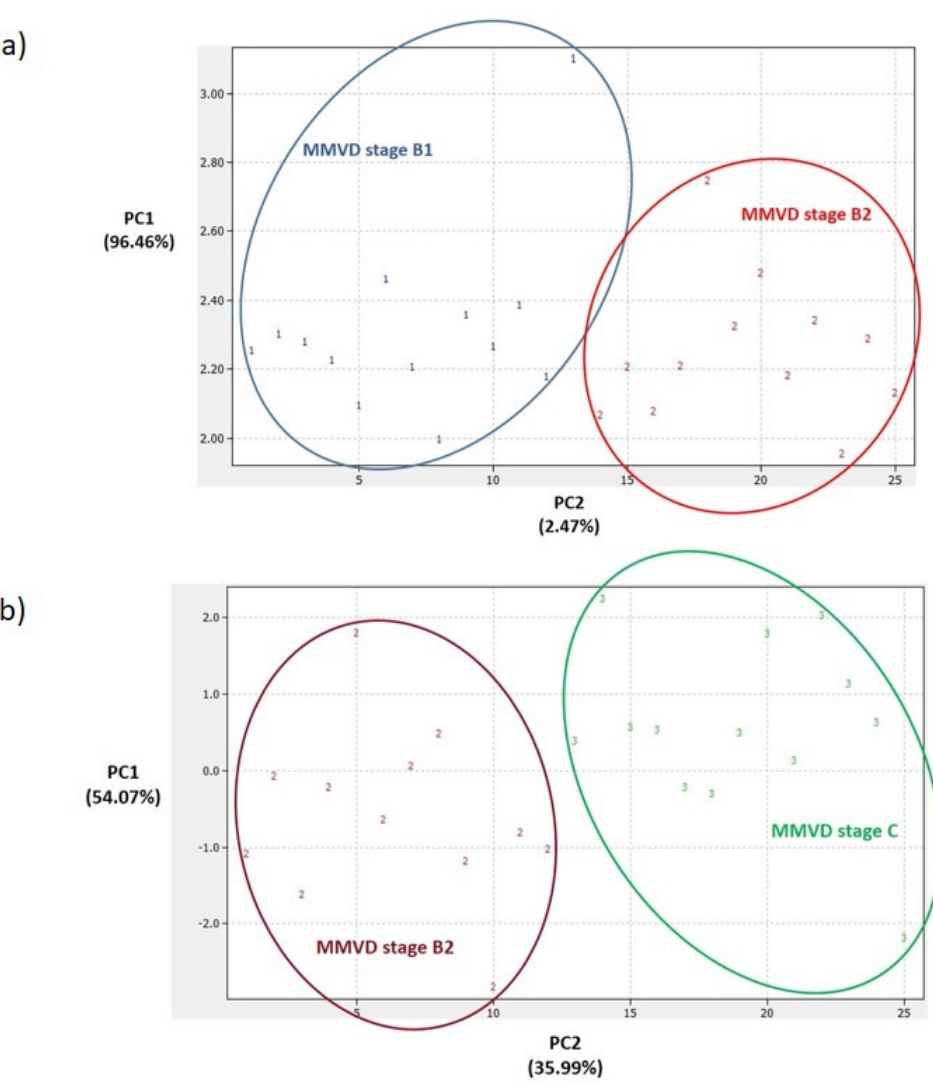
Figure 4. Principal component analysis (PCA) score plots. Clear differentiation between groups with consecutive myxomatous mitral valve disease (MMVD) stages B1 and B2 ( a ) and between groups with MMVD stages B2 and C ( b ). In preparing the plots, relative abundance ratios of proteins with statistically different abundances (Figure 2) were used for the PCA. The PCA was performed in DataLab software. Class numbers: 1 = MMVD stage B1 (N = 13 biological replicates), 2 = MMVD stage B2 (N = 12 biological replicates), 3 = MMVD stage C (N = 13 biological replicates), 4 = healthy/control group (N = 12 biological replicates). N represents the number of serum samples (biological replicates).